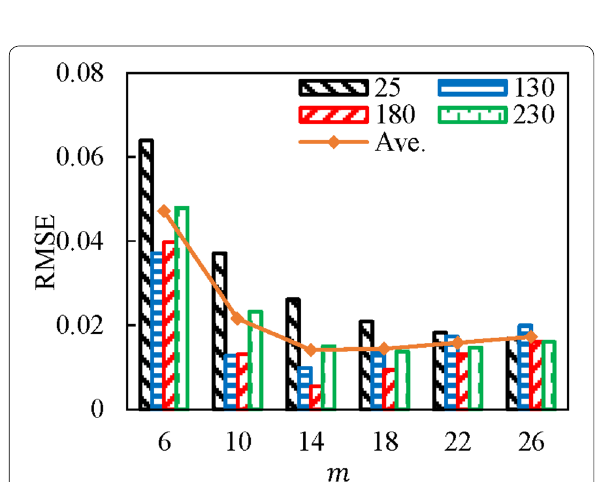
Figure 16 RMSEs calculated by Yld2000-2d criterion with different exponent factors at 25 °C, 130 °C, 180 °C and 230 °C (1) The von Mises, Hill48 and Yld2000-2d yield func- tions are calibrated using uniaxial yield stresses and r -values at 0°, 45°, 90° to the RD, the equi-biaxial